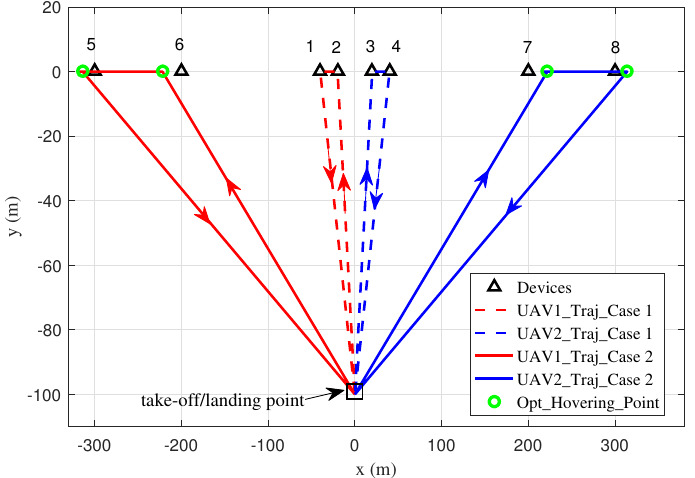
Figure 5. Optimal trajectories of the two UAVs for the quasi-stationary scenario with T = 26 s.